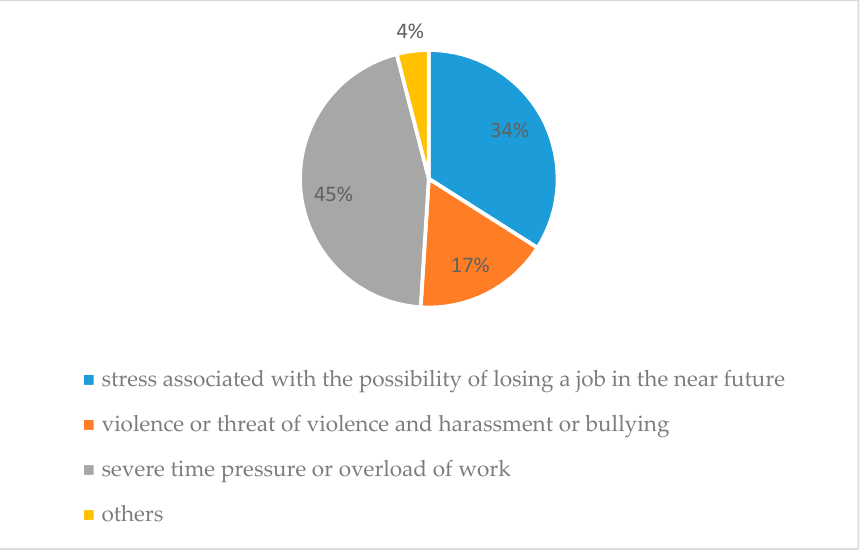
Figure 5. Structure of psychological threats as work-related health problems in 2014 in Poland (Statistics Poland 2014).